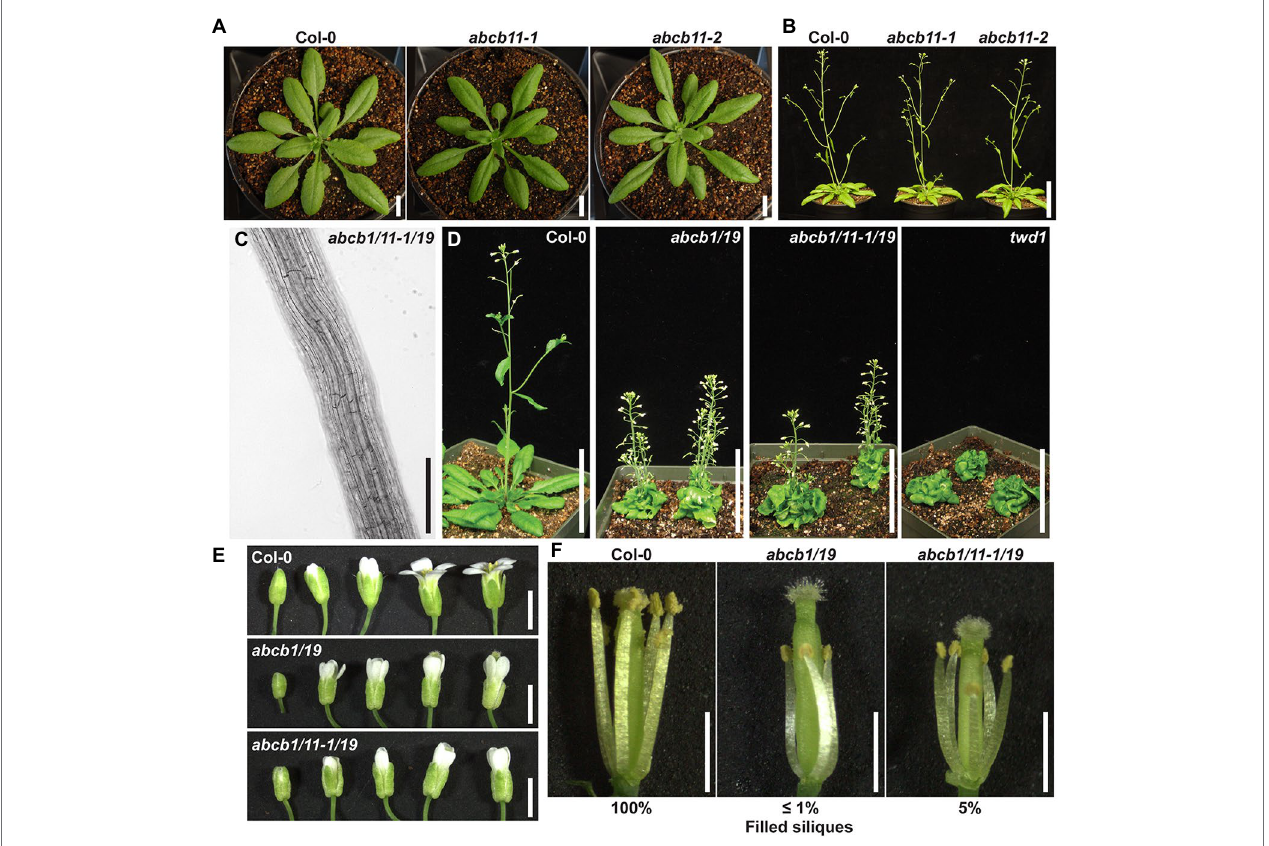
FIGURE 6 | ABCB11 contributes to auxin phenotypes supplementary to ABCB1/19 . (A) Col-0 and abcb11 rosettes at time of bolting. (B) Col-0 and abcb11 mature plants. (C) Root cell files of 7-day light-grown abcb1/11-1/19 seedlings. Images were converted to black and white, and brightness and contrast were adjusted to show cell files. (D) 35-day rosettes and inflorescences of Col-0, abcb1/19 , abcb1/11-1/19, and twd1 . (E) Flower series of Col-0, abcb1/19 , and abcb1/11-1/19 . (F) Col-0 , abcb1/19 , and abcb1/11-1/19 flowers with petals removed. Scale bars: (A) 1 cm, (B,C) 5 cm, (D) 200 μ m, (E,F) 1 mm.